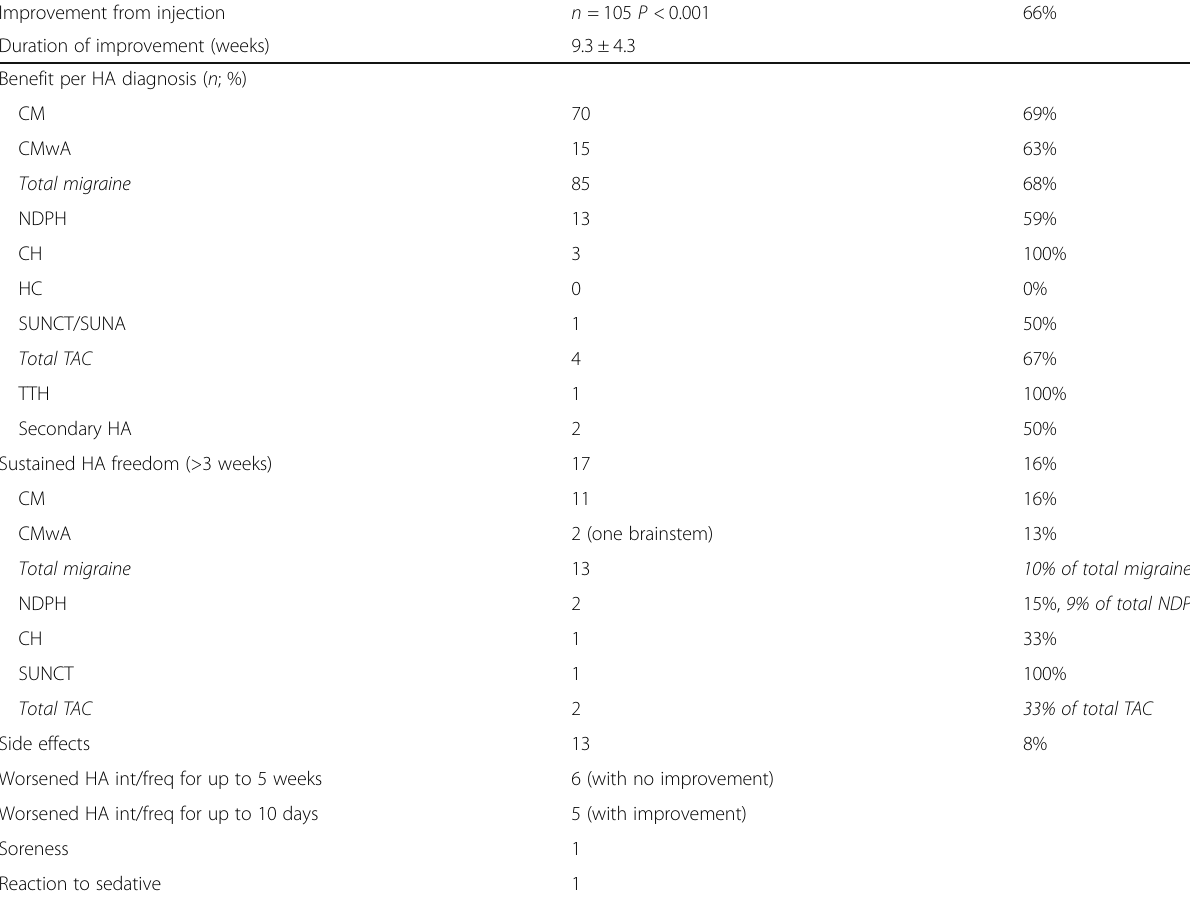
Table 2 Effects of first greater occipital nerve injection in 159 chronic headache patients with available follow-up Improvement from